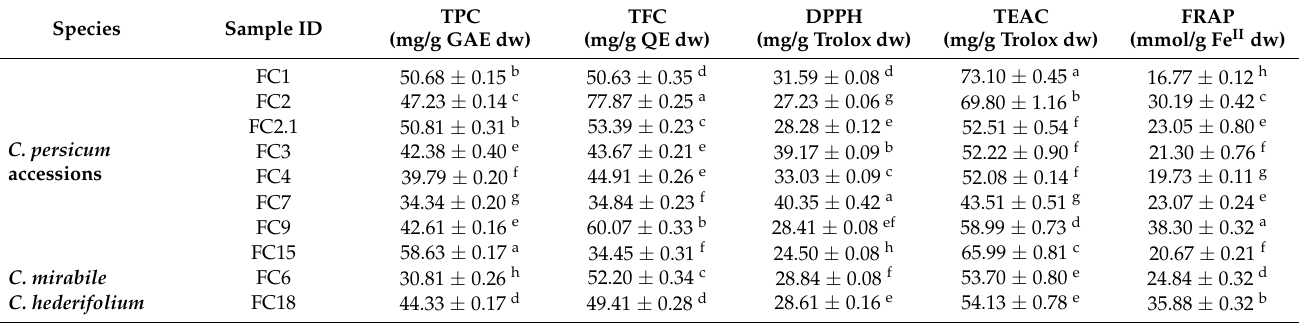
Table 5. Total phenolic (TPC) and flavonoid (TFC) content, and antioxidant properties of tested Cyclamen flower extracts.